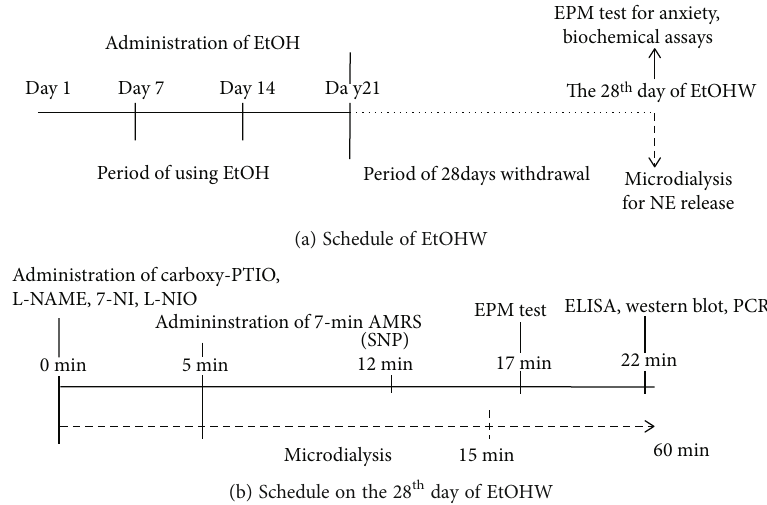
Figure 1: (a) Time schedules for EtOHW and (b) the 28 th day of